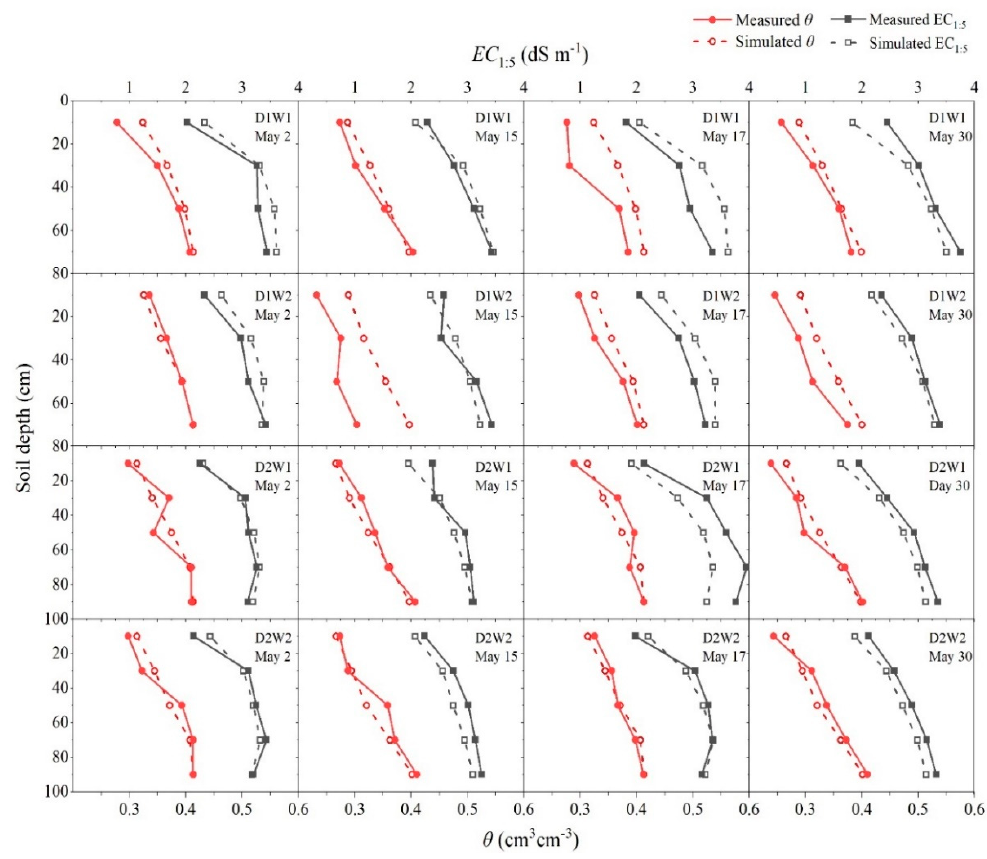
Figure 4. Comparison of measured and HYDRUS simulated water content and salt content (EC 1:5 ) at the indicated time for all treatments. Table 3. Statistical errors parameters (RMSE, MAE, ME, R 2 ) for the comparison between measured and simulated soil water and salt contents (EC 1:5 ) in different treatments.